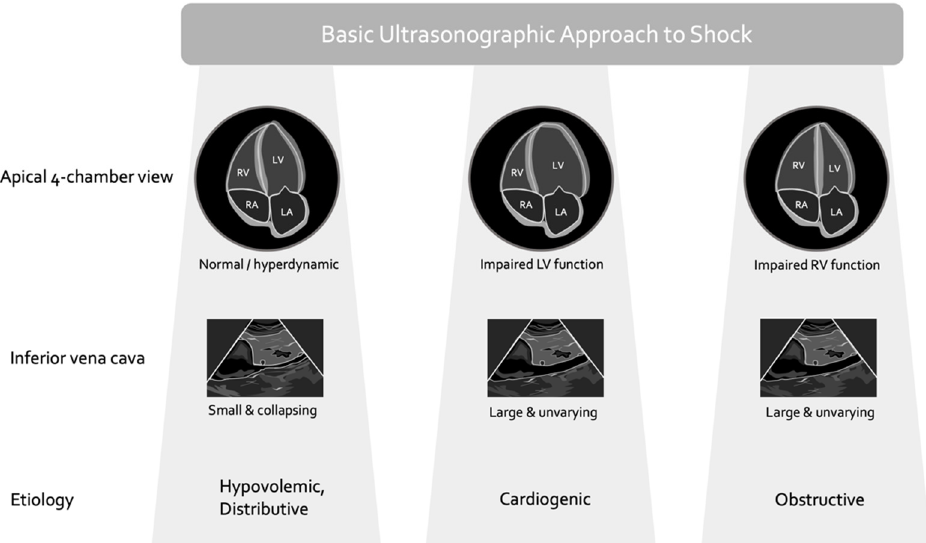
Figure 1. Basic ultrasonographic approach to shock. RA and LA are right and left atria; RV and LV are right and left ventricles. These are simplifications, obstructive shock may be due to pericardial effusion or tension pneumothorax in addition to pulmonary emboli or severe acute respiratory distress syndrome (ARDS). Additionally, shock is often multifactorial; e.g., a patient with septic shock from pneumonia complicated by severe ARDS may have all 4 etiologies occurring in